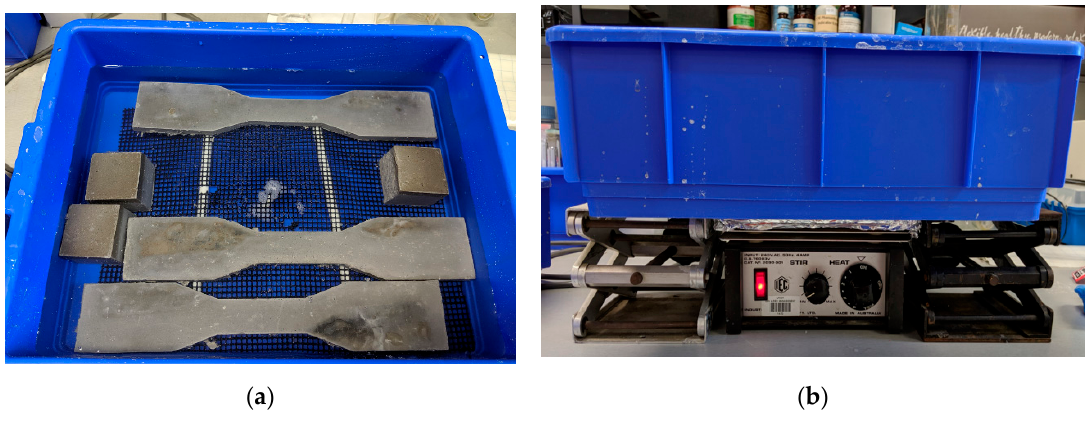
Figure 5 ( a ) and ( b ) . Sulfuric acid bath with magnetic stirrer . Figure 5. ( a , b ) . Sulfuric acid bath with magnetic